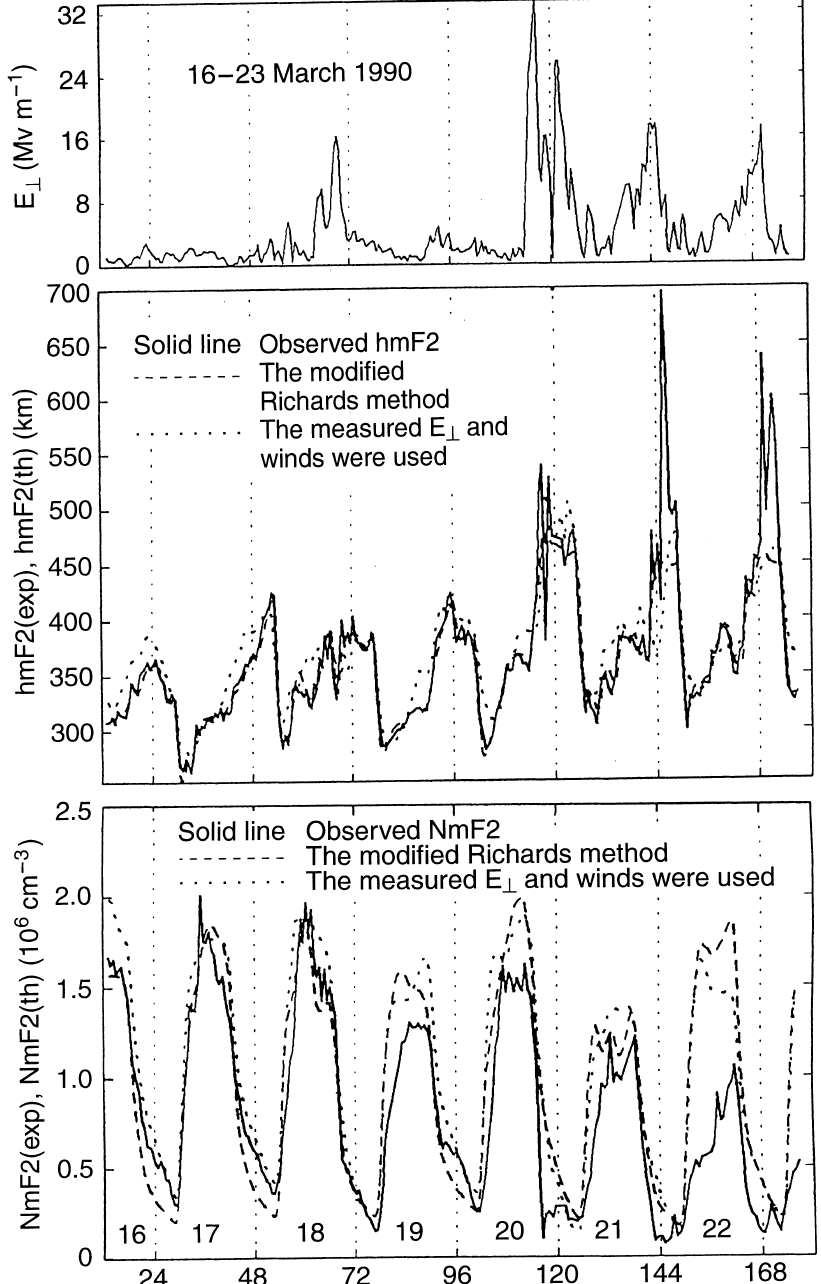
Fig. 9. The measured E at the hmF2 ? altitude ( top panel ), the measured and modeled hmF2 ( middle panel ), and the measured and modeled NmF2 ( bottom panel ) during the 16–23 March 1990 period for the EUVAC solar flux model. The solid lines are the Millstone Hill data (Buonsanto et al ., 1992a). The dotted lines show the results when we use no E in the model and the approach ? based on the method of Richards (1991) for obtaining equivalent neutral winds from the height of the F2 peak electron density, whereas the dashed lines were obtained when the measured E and meridional neutral ? winds were used. All the model results have been obtained from the IZMIRAN model with the Boltzmann populations of the first five vibrational levels of N 2 ( v ), the O (cid:135) (cid:255) O frequencies given by Salah (1993) and the original recombination rate of O (cid:135) (cid:133) 4 S